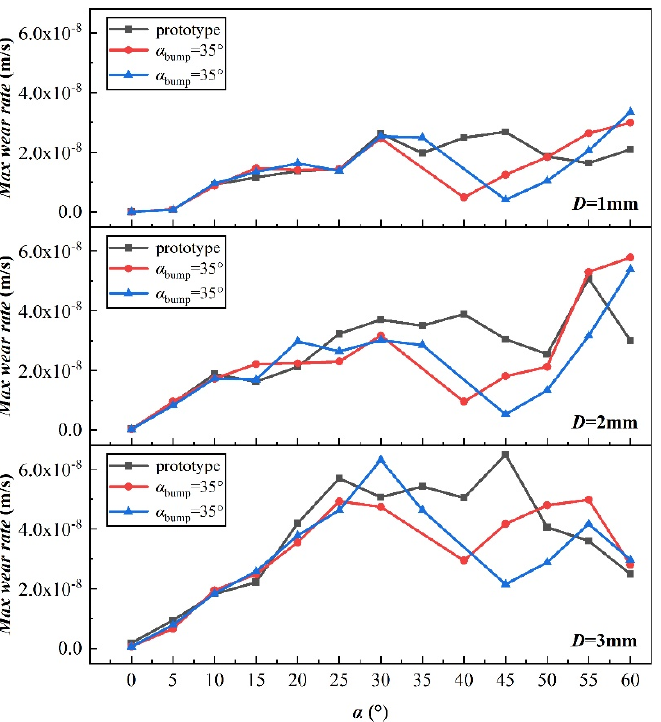
Figure 16. The maximum wear rate of each angle of the outer wall surface for different particle